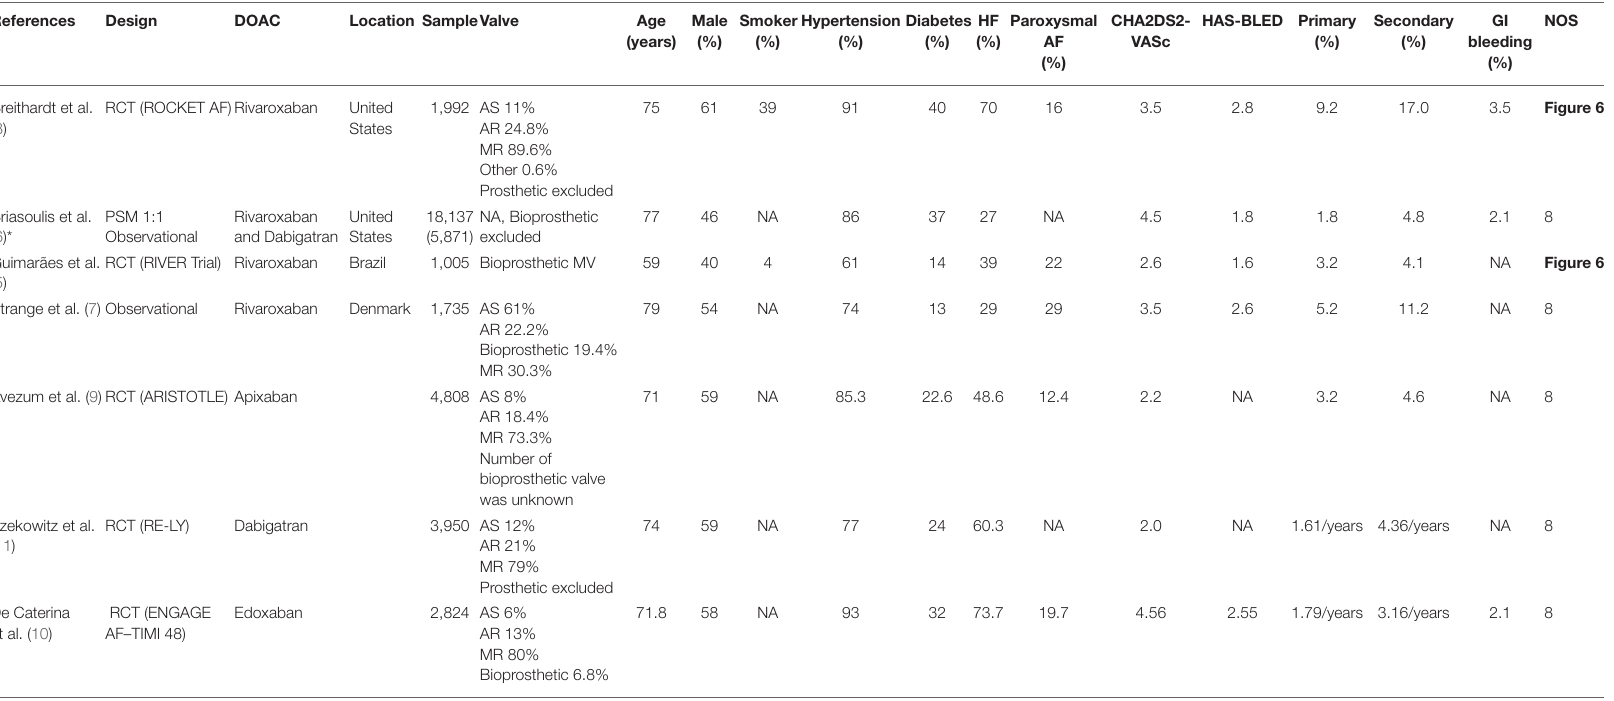
TABLE 1 | Baseline characteristics of the included